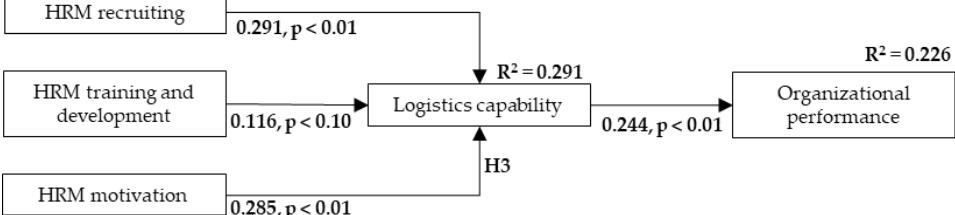
Figure 2. The results showing the significant paths. Note: Control variables have been omitted for clarity reasons.